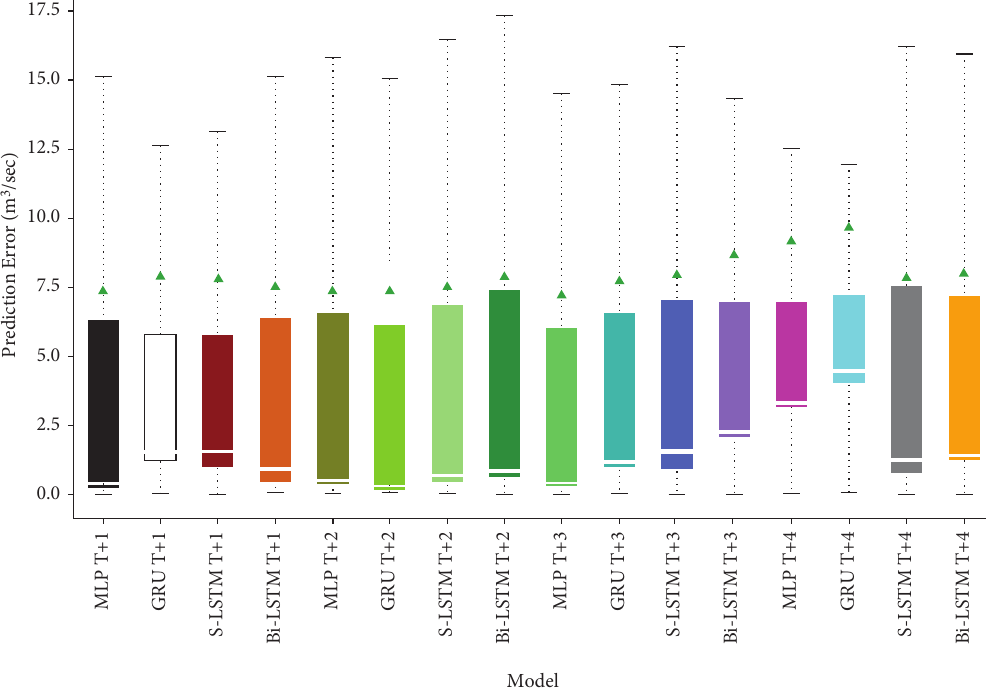
Figure 11: Spread of prediction error (m 3 /s) or box plot for the proposed models during the test period (Gummera